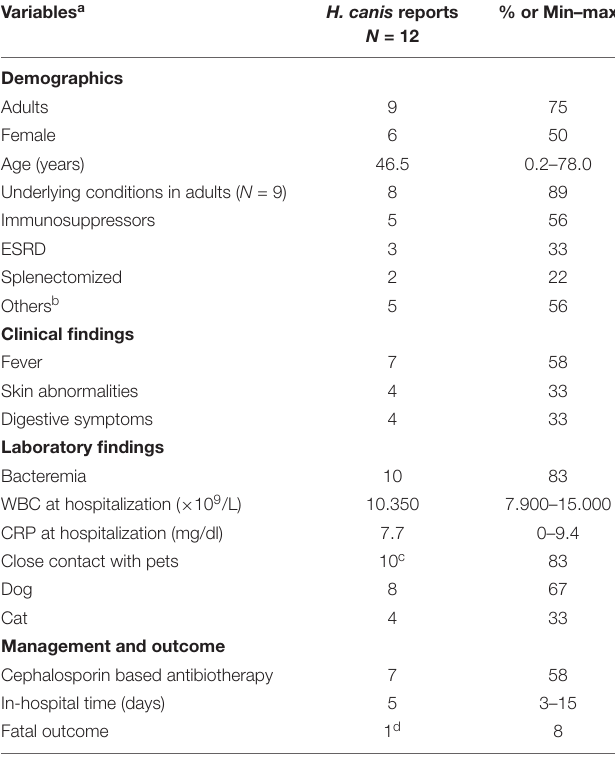
TABLE 2 | Clinical features of previous and current Helicobacter canis